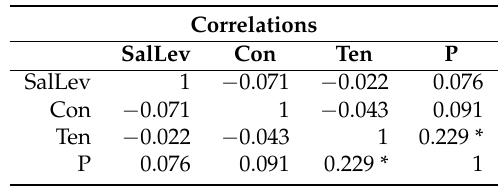
Table 4. Pearson Correlations between the independent variables of the linear regression models described in Equations (4) and (5) for data collected in January 2011. * The correlation is significant at the 0.05 level